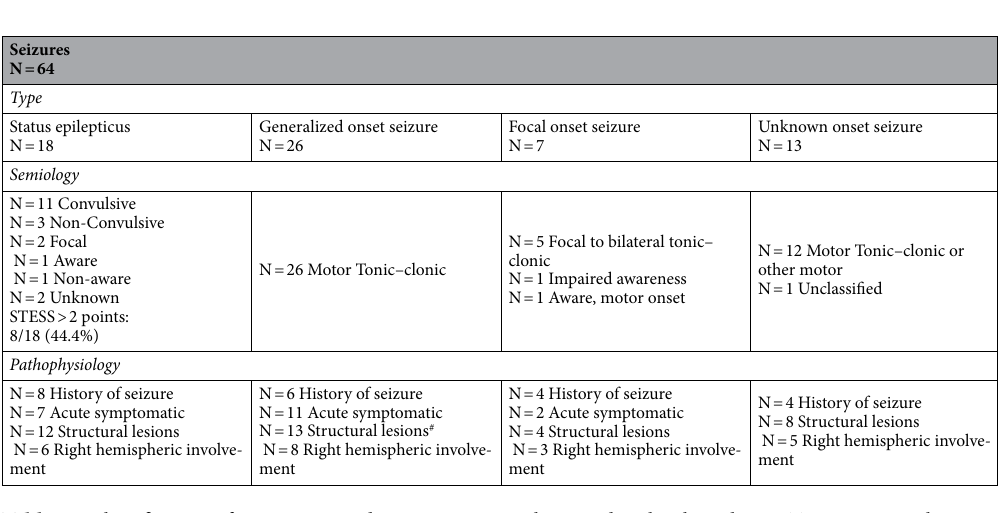
Table 2. Classification of seizures according to type, semiology, and pathophysiology. STESS Status epilepticus severity score. # Data on structural lesions were available in 24 patients.